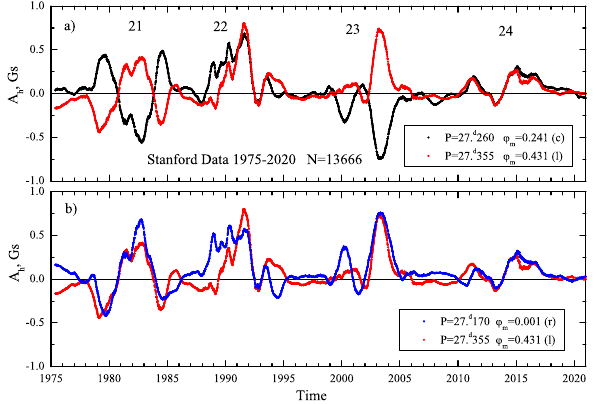
Figure 11. Changes in oscillation amplitudes with time for the left triplet of peaks from Figure 9a: a) for the central (black) and left (red) components, b) for the left (red) and right (blue)